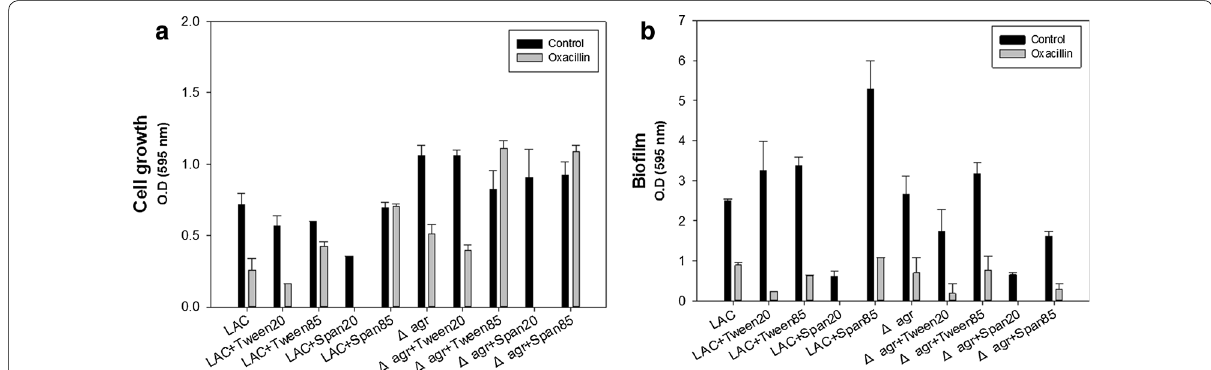
Fig. 5 Synergistic effect of surfactants and oxacillin. a Cell growth of the LAC and Δ agr mutant strains with surfactants. b Biofilm formation of the LAC and Δ agr mutant strains with surfactants. The cell was grown for 48 h in the presence of 0.1% (v/v) of the surfactant supplements for the comparative analysis of cell growth and biofilm formation. The error bars represent the standard deviation of three